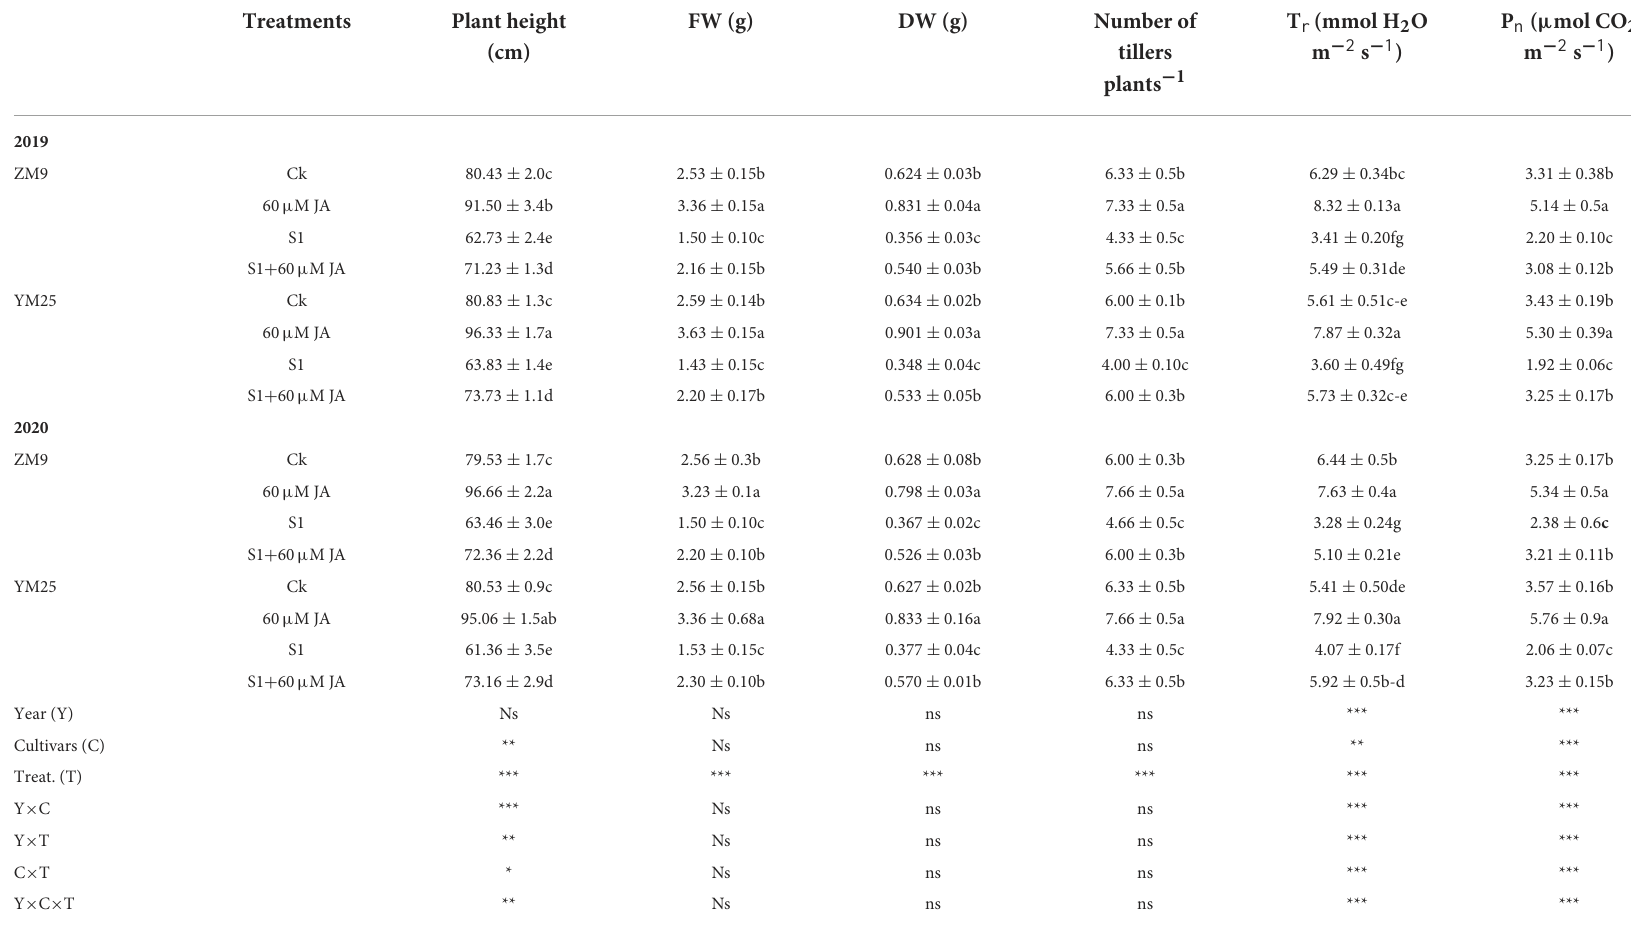
TABLE 1 Effects of JA priming on plant height, FW, DW, number of tillers/plants, T r and P n of two wheat cultivars Mai9 (ZM9, salt-sensitive) and Yang Mai25 (YM25, salt-tolerant) under control and salinity stress conditions during two consecutive growing seasons 2019 and 2020. Treatments Plant